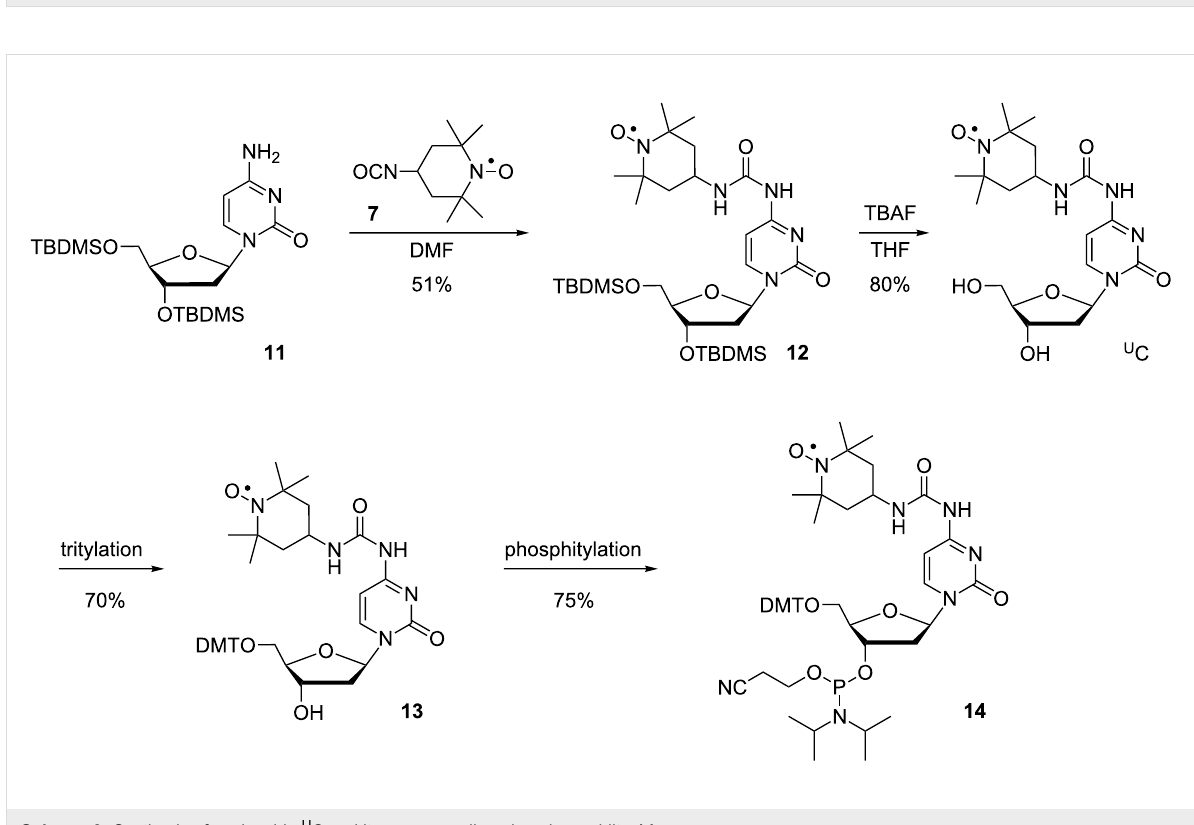
Scheme 2: Synthesis of nucleoside U A and its corresponding phosphoramidite 10 .